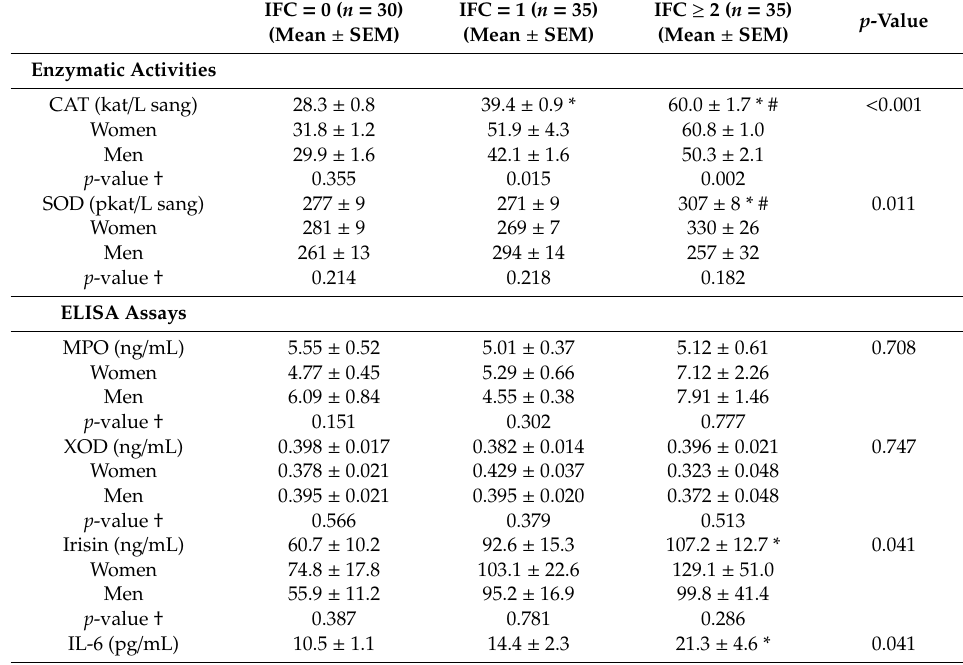
Table 2. Oxidative stress and inflammatory markers in the plasma of patients with NAFLD according to the intrahepatic fat content